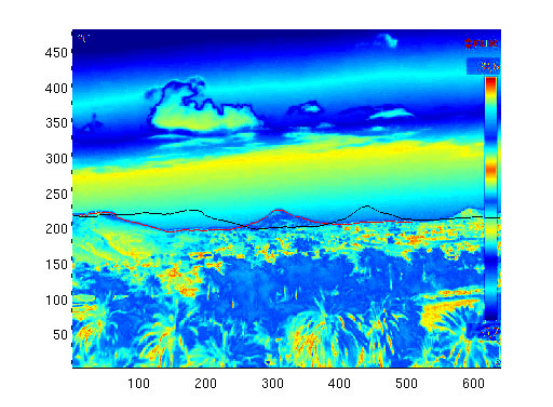
Figure 7. Pitch, roll, and yaw offset determination based on the sky–terrain interface.